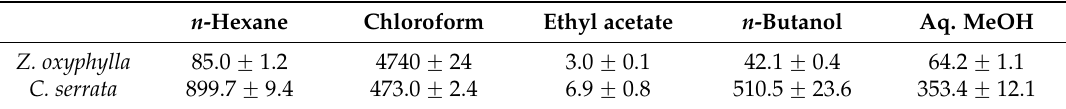
Table 4. DPPH radical scavenging activity (IC 50 , mg/mL) of sub-fractions of the ethyl-acetate fraction of Z. oxyphylla and C. serrata .